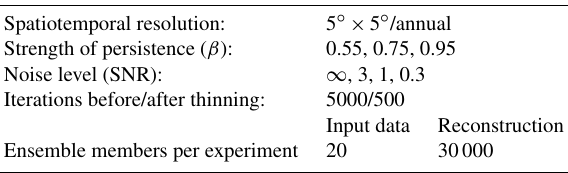
Figure 2. The spatial domain of the reconstruction experiments. Dots mark locations of instrumental sites, proxy sites are high- lighted by red circles. The superimposed map of Europe provides a spatial scale. Table 1. Summary of the experiment setup. Spatiotemporal